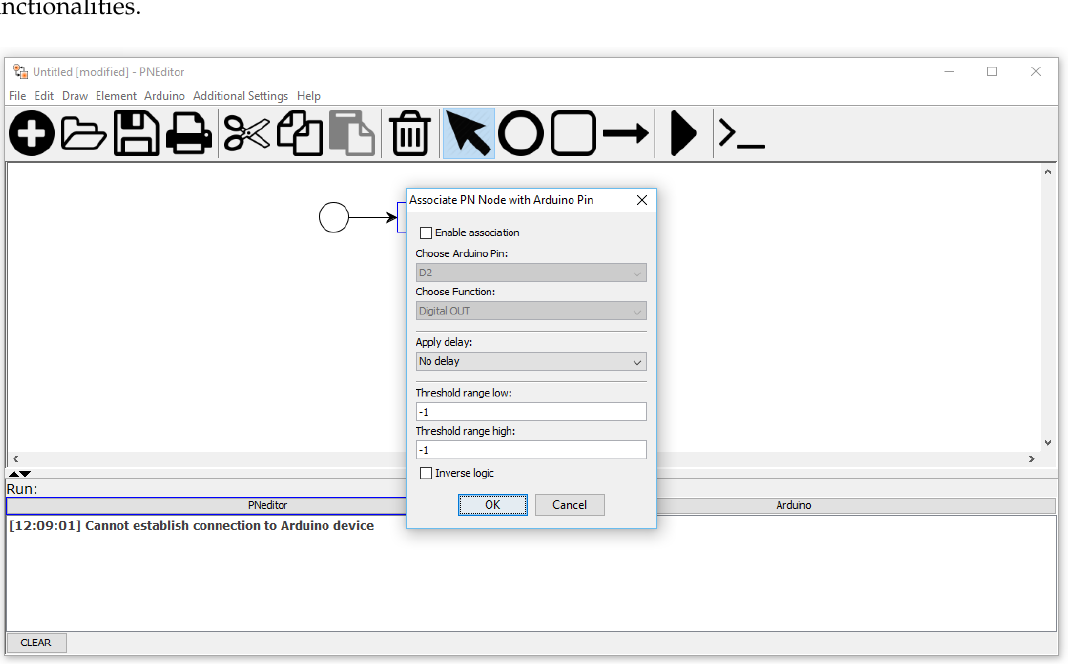
Figure 6. GUI of developed extension of PNEditor named PetriNet